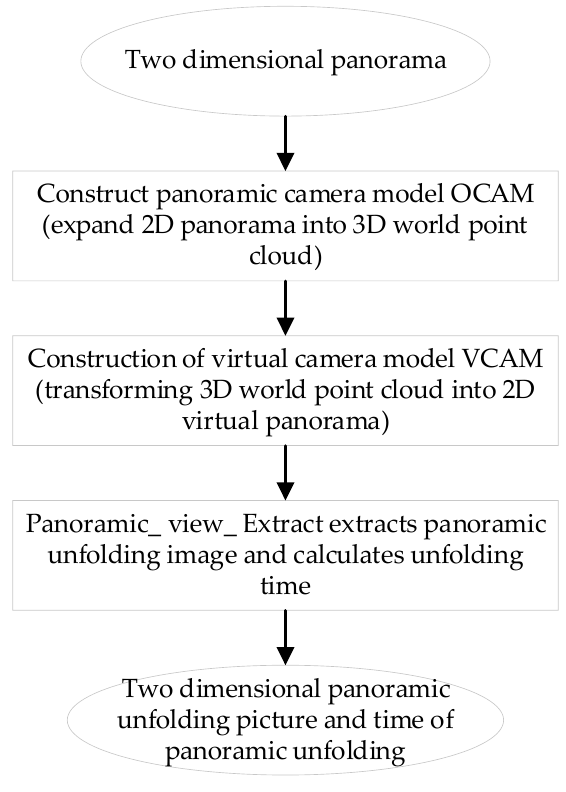
Figure 15. Panoramic image expansion flow chart.